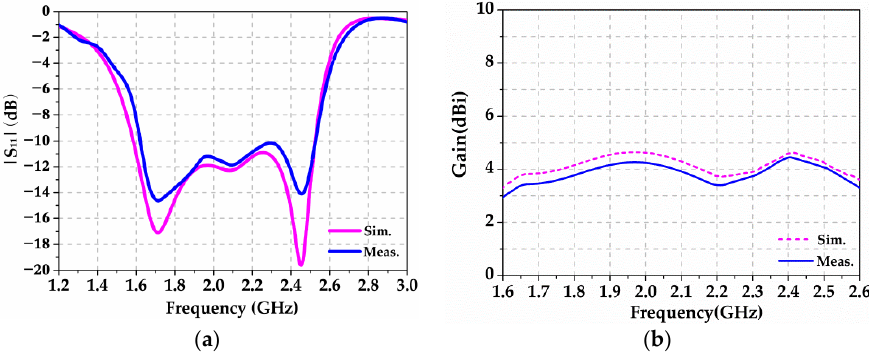
Figure 12. Simulation and measurement results of State-II: ( a ) | S 11 |; ( b ) Gain .